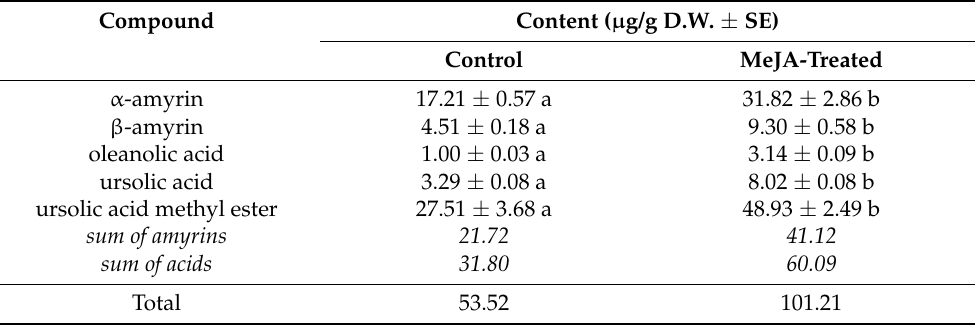
Table 2. The content of triterpenoids in the T. × media KT hairy root line after elicitation with 100 µ M